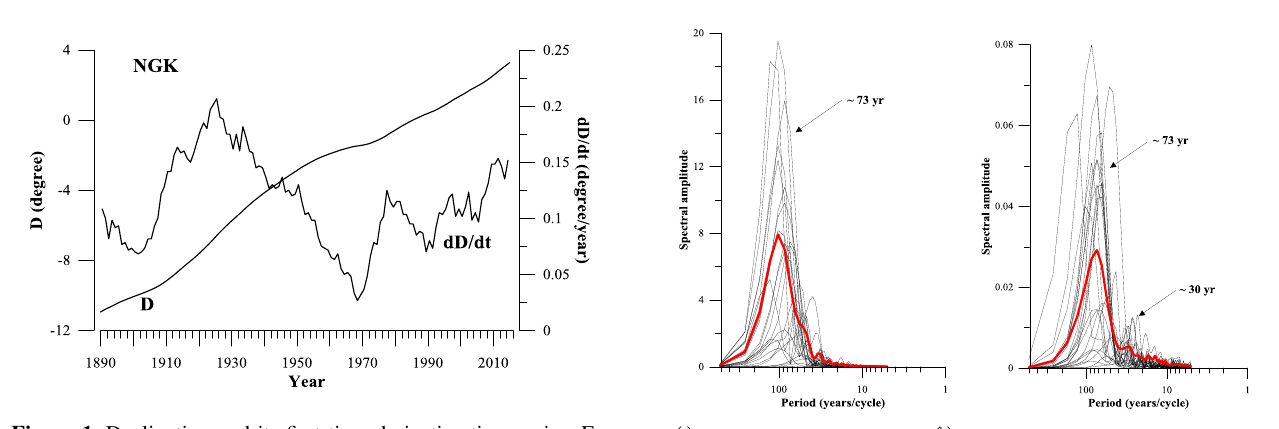
Figure 1. Declination and its first time-derivative time series. Ex- ample for a high-standards geomagnetic observatory (Niemegk, NGK). Figure 2. FFT power spectrum: observatory declination time series